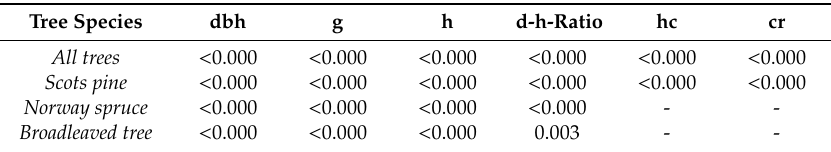
Table 5. The p-values from the paired-sample t-tests indicating the significance of the di ff erences between the TLS-derived estimates of tree attributes, such as diameter-at-breast-height (dbh), basal area (g), tree height (h), diameter-height-ratio (d-h-ratio), and crown ratio (cr) by tree species measured in 2014 (T1) and 2019 (T2).